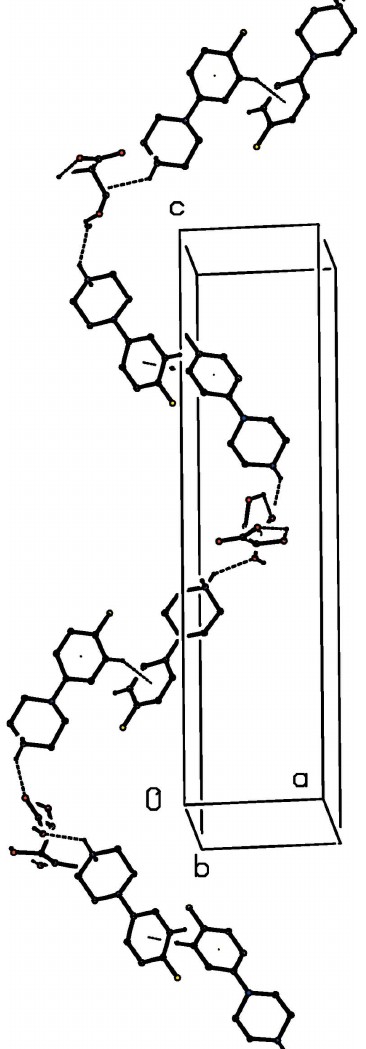
Figure 8 Part of the crystal structure of compound (III) showing the formation of a hydrogen-bonded chain of cations and anions running parallel to the [001] direction. Hydrogen bonds are drawn as dashed lines and, for the sake of clarity, the water molecules and the H atoms not involved in the motif shown have been